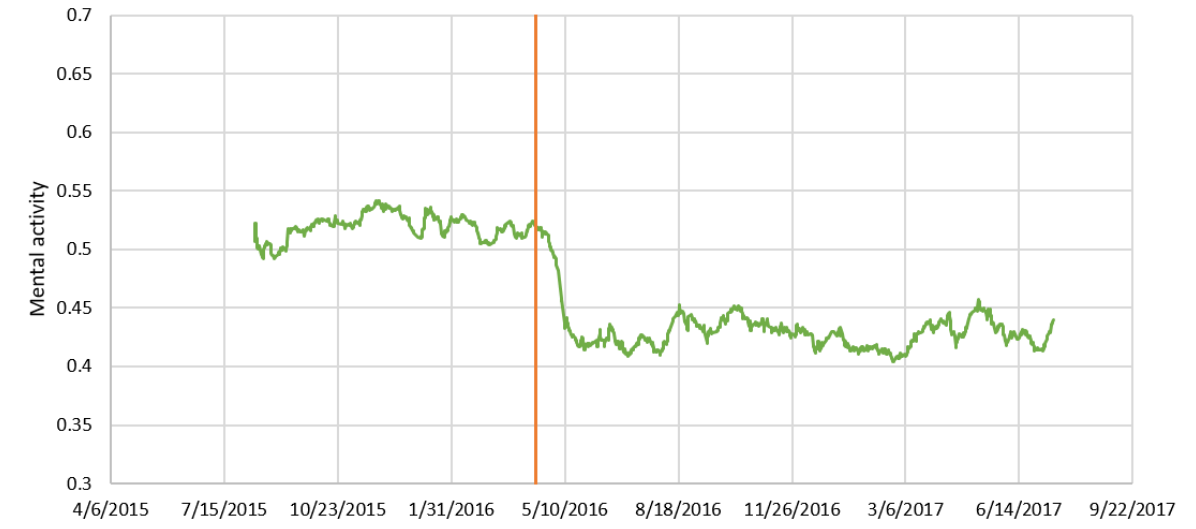
Figure 13. Change over time in mental activity for one victim of the Kumamoto